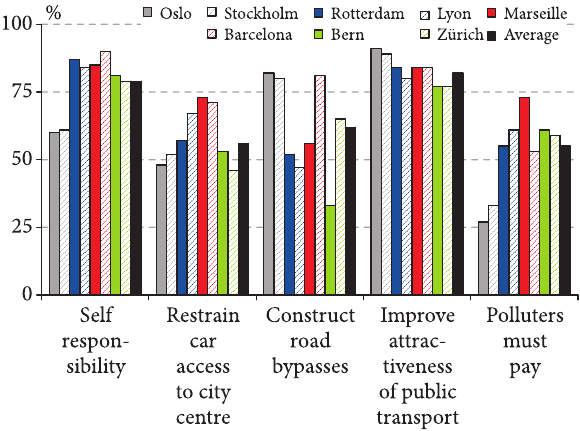
fig. 1. How to cope with congestion and environmental